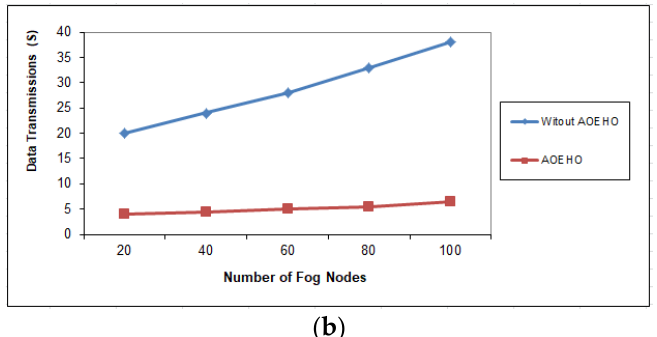
Figure 10. Data transmission between fog nodes = 100 nodes. ( a ) Size of data replication = 64 MB. ( b ) Size of data replication = 320 MB.